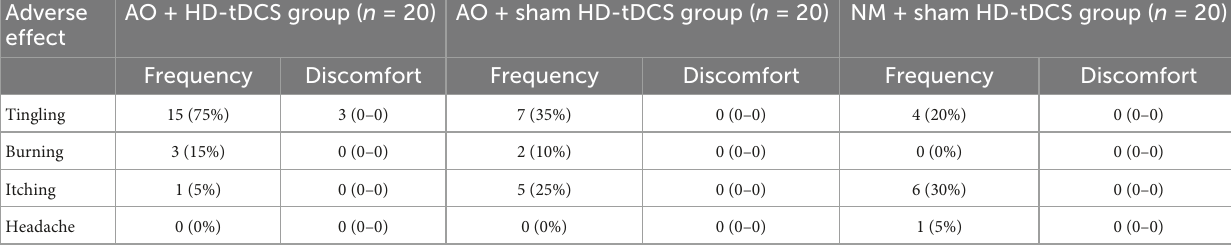
TABLE 2 Frequency and discomfort of adverse effects. Adverse